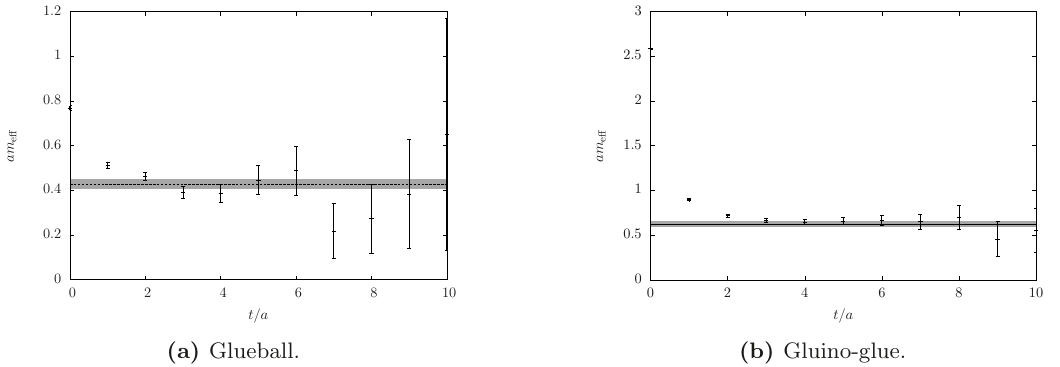
Figure 3. Mass plateau of the gluino-glue and the 0 ++ glueball for β = 5 . 5, κ = 0 . 1673, on a 16 3 × 32 lattice. The final value indicated by the gray line is obtained from a fit of the correlation